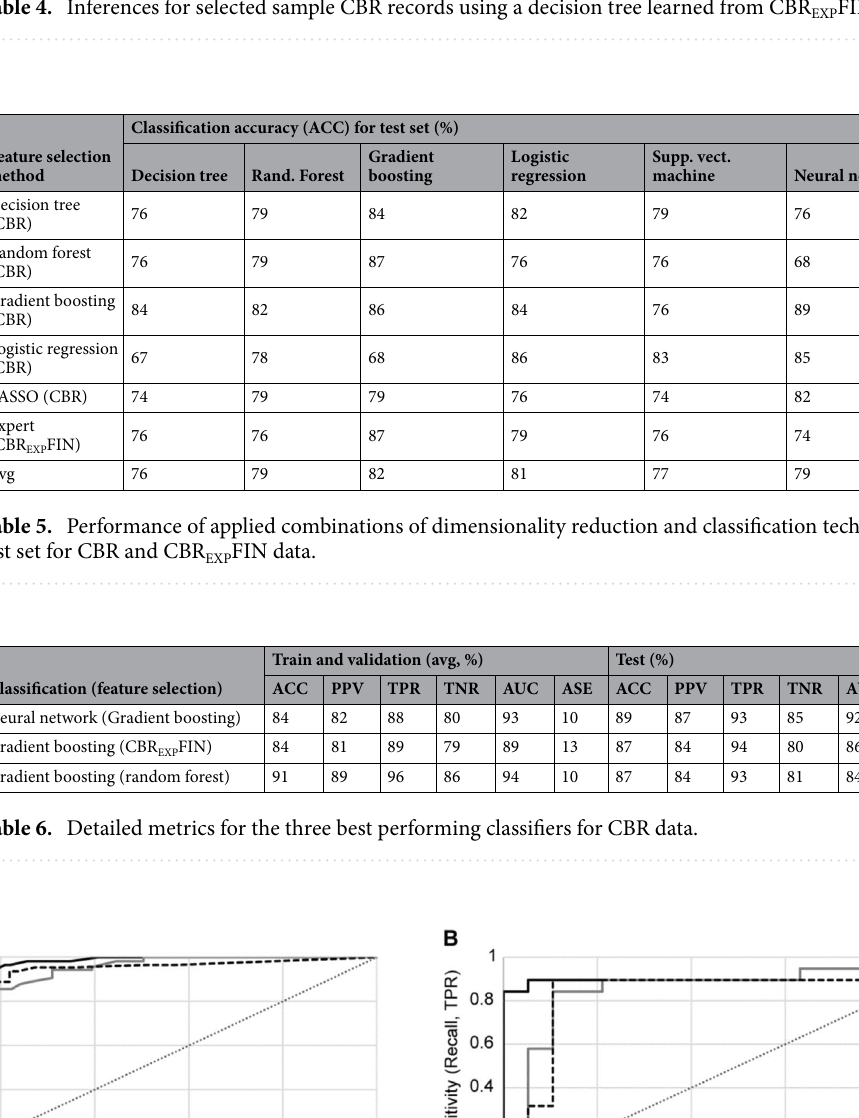
Table 4. Inferences for selected sample CBR records using a decision tree learned from CBR EXP FIN variables.